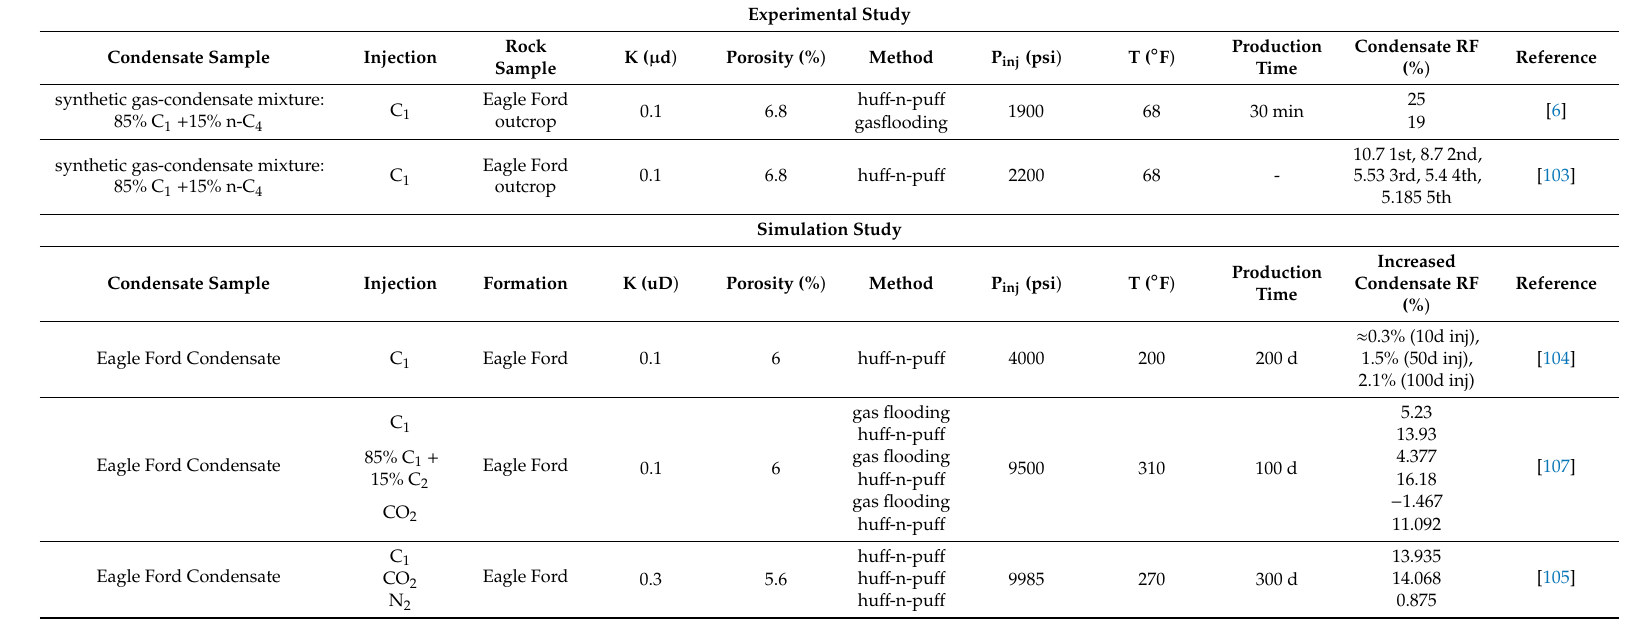
Table 5. The experimental and simulation studies about di ff erent gas injection approaches in shale condensate reservoirs for enhanced condensate